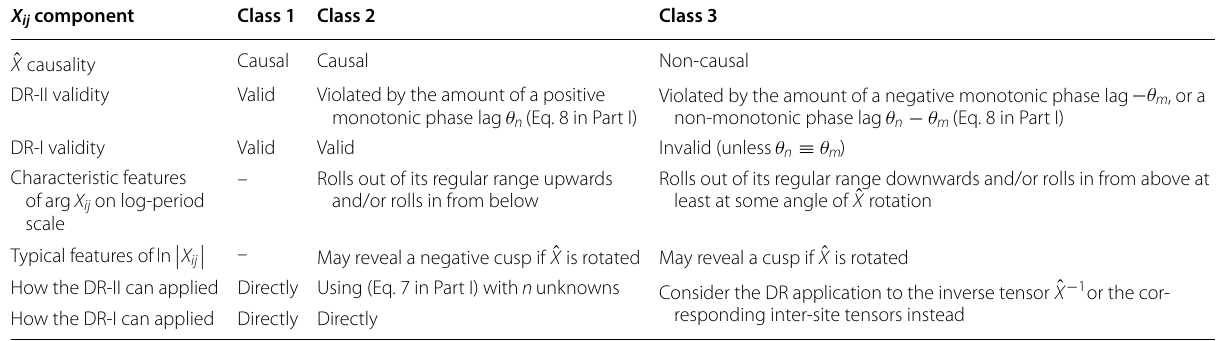
How the DR-II can applied Directly Using (Eq. 7 in Part I) with n Class 1—refers to MP components of a causal tensor, class 2—to non-MP components of a causal tensor, and class 3—to all components of a non-causal tensor